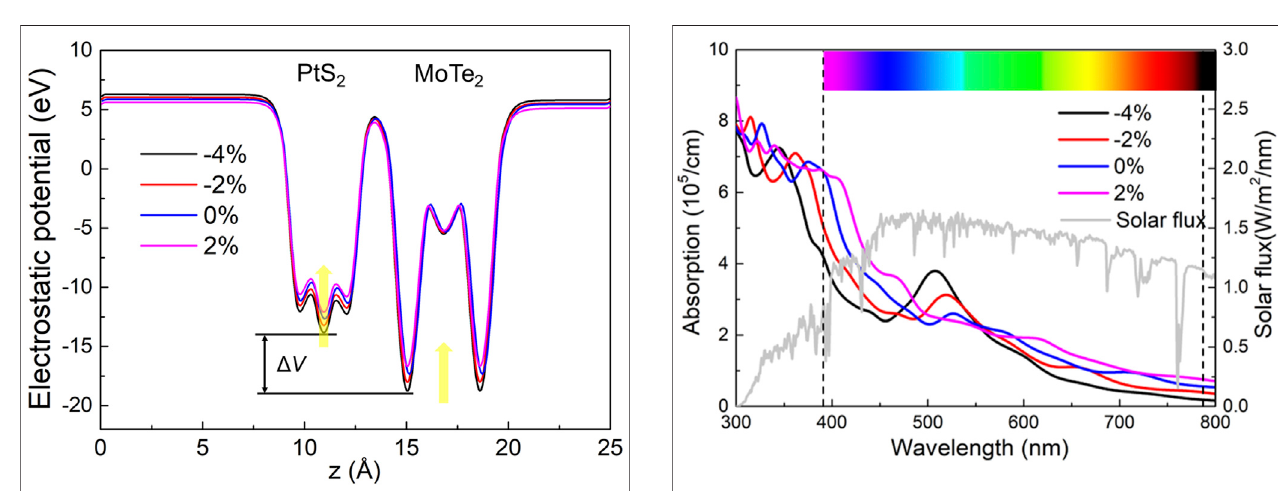
FIGURE 5 | Potential drop of the MP vdW heterostructure across the interface by different external strains.